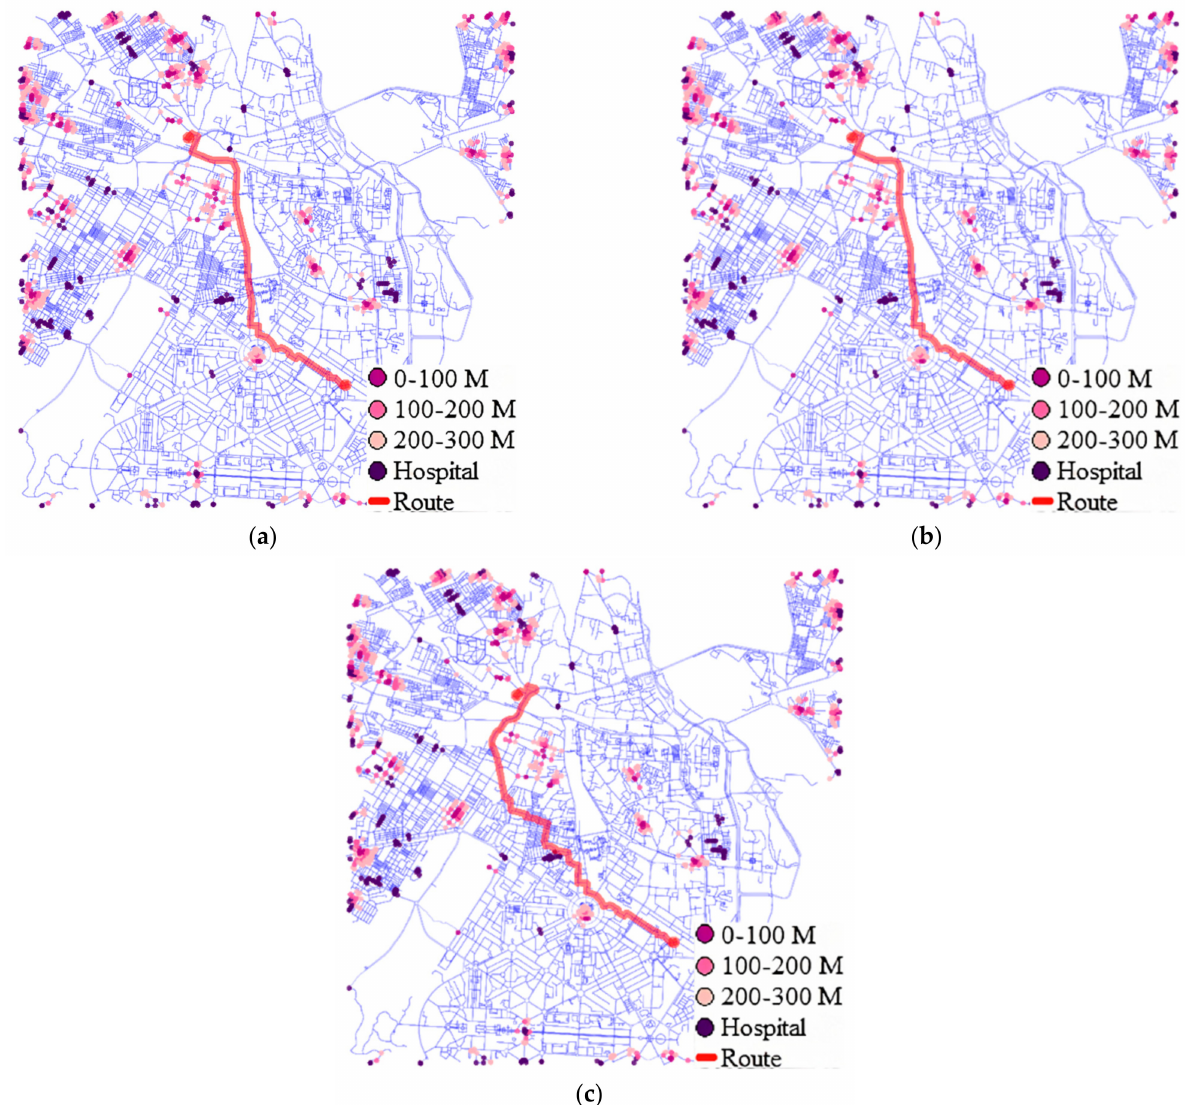
Table 1. ( c ) New-path between origin and destination based on case 2 of Table